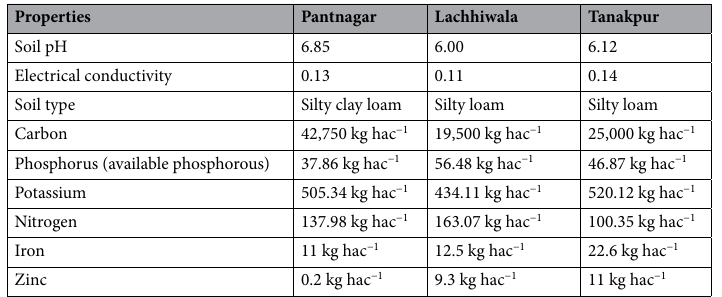
Table 1. Soil physico-chemical properties in three different Shisham provenances. Each value is the mean of three replicates. Data was analysed statistically at the 5% (p < 0.05) level of significance.